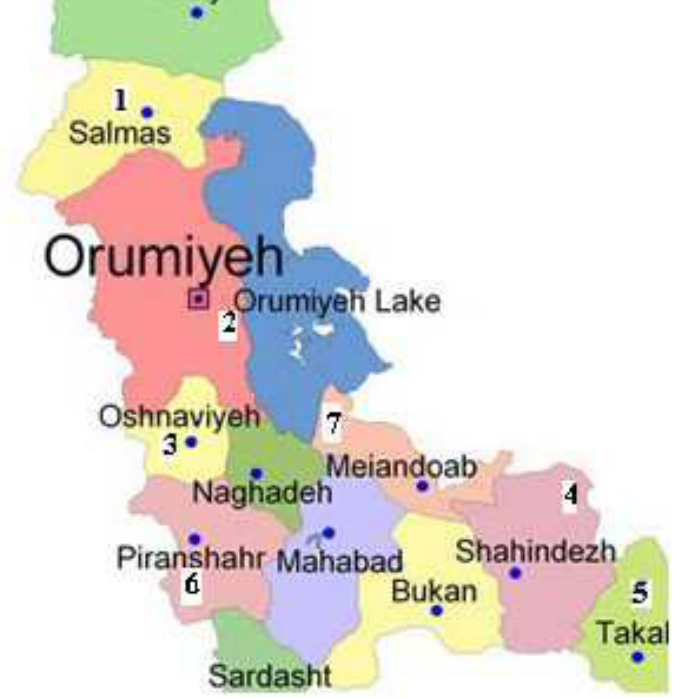
F IGURE 1. Localities samples in West